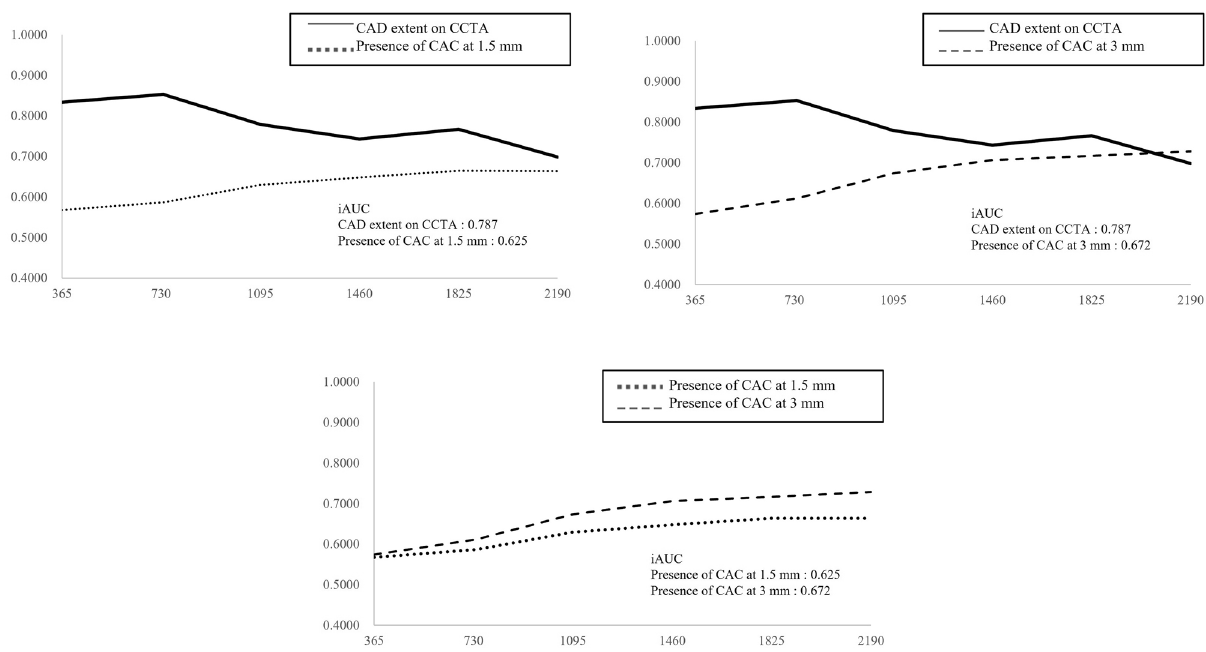
Figure 2. Predictive accuracy of three different models for MACEs: iAUC by follow-up time. There were no statistically significant differences among the three models. ( a ) Model 1: CAD extent. ( b ) Model 2: the presence of CAC with 1.5 mm slice thickness. ( c ) Model 3: the presence of CAC with 3 mm slice